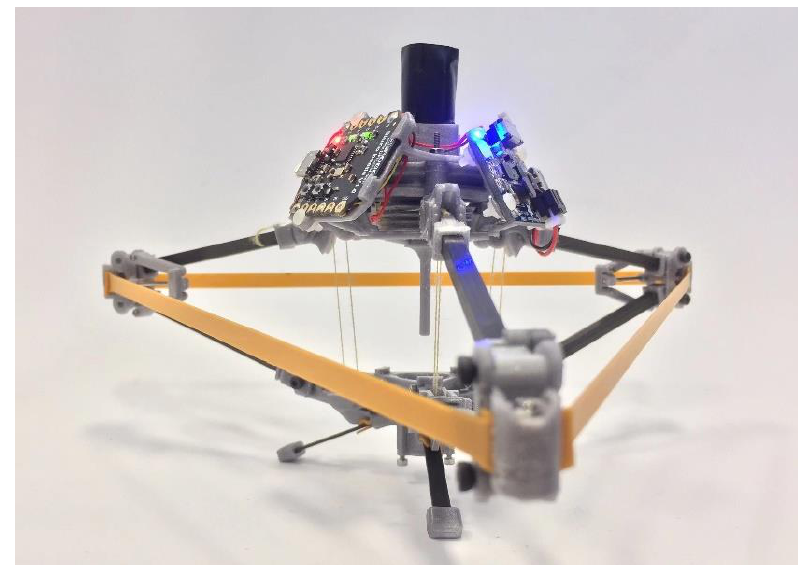
Figure 2. The three-legged jumping robot in compressed position [17].